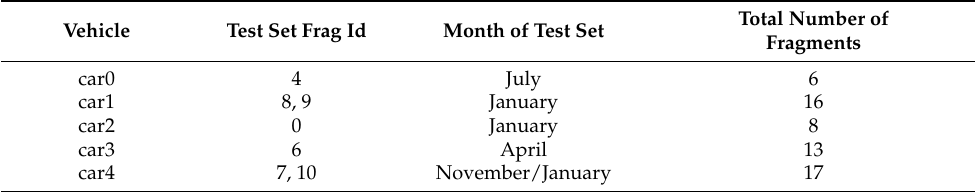
Table 4. Randomly selected test